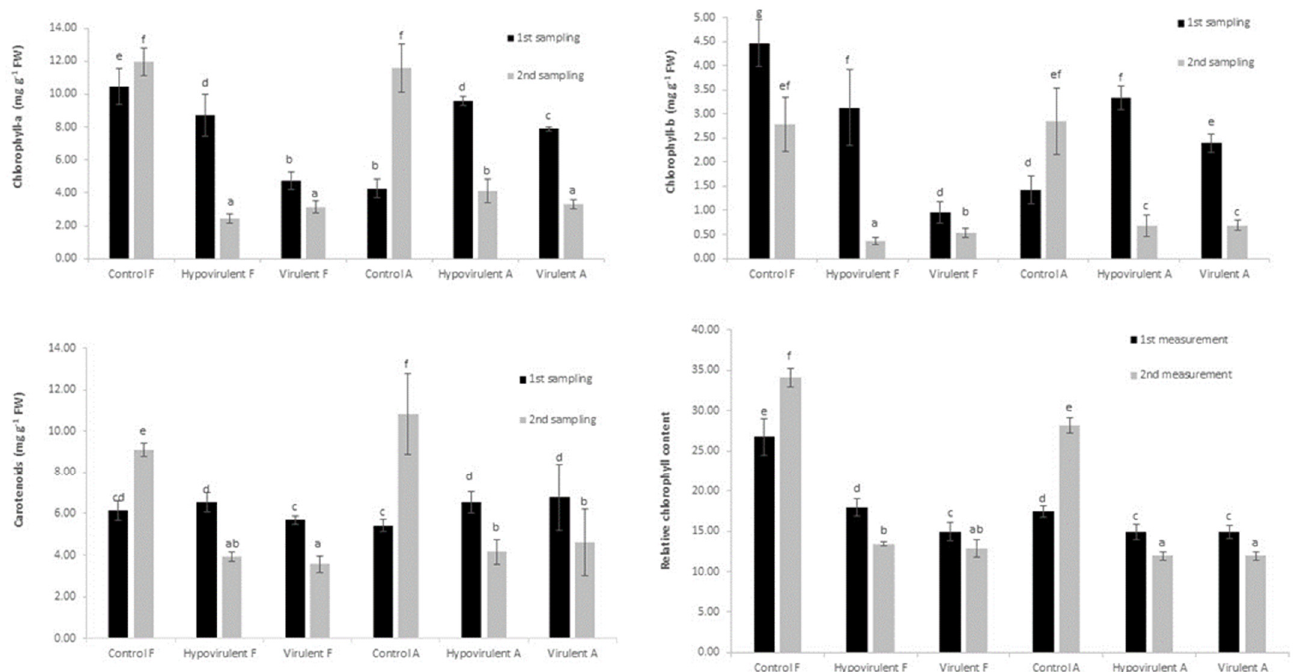
Figure 1. Chlorophyll-a, chlorophyll-b, carotenoids, and relative chlorophyll content (SPAD-Units) after the artificial infection (first measurement after 21 days from infection, second measurement after 42 days). Values are means ± SD, n = 25. Significant differences among samples based on the Tukey-HSD test. F: leaves above the infection, A: leaves below the infection.